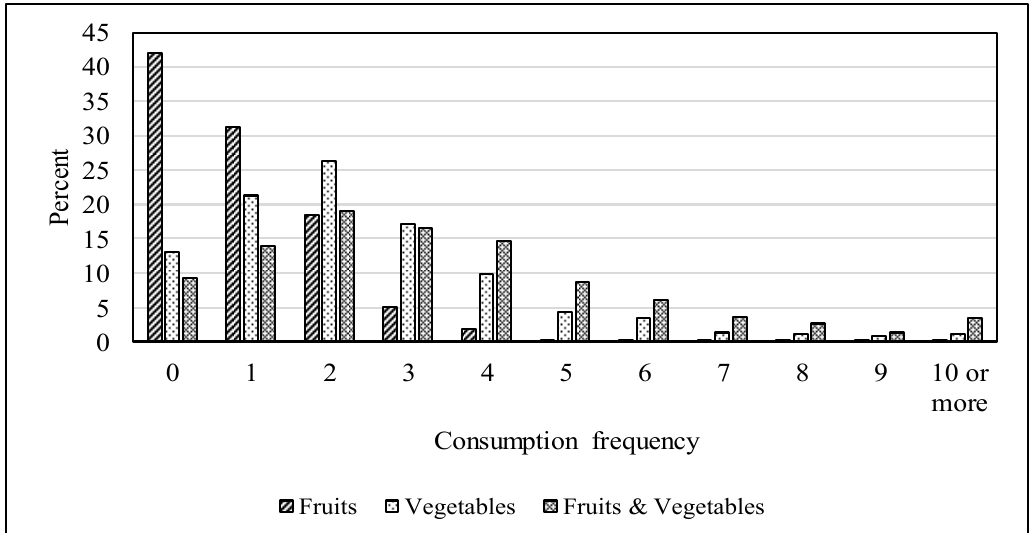
Figure 1. Frequency of fruits and vegetable consumption.